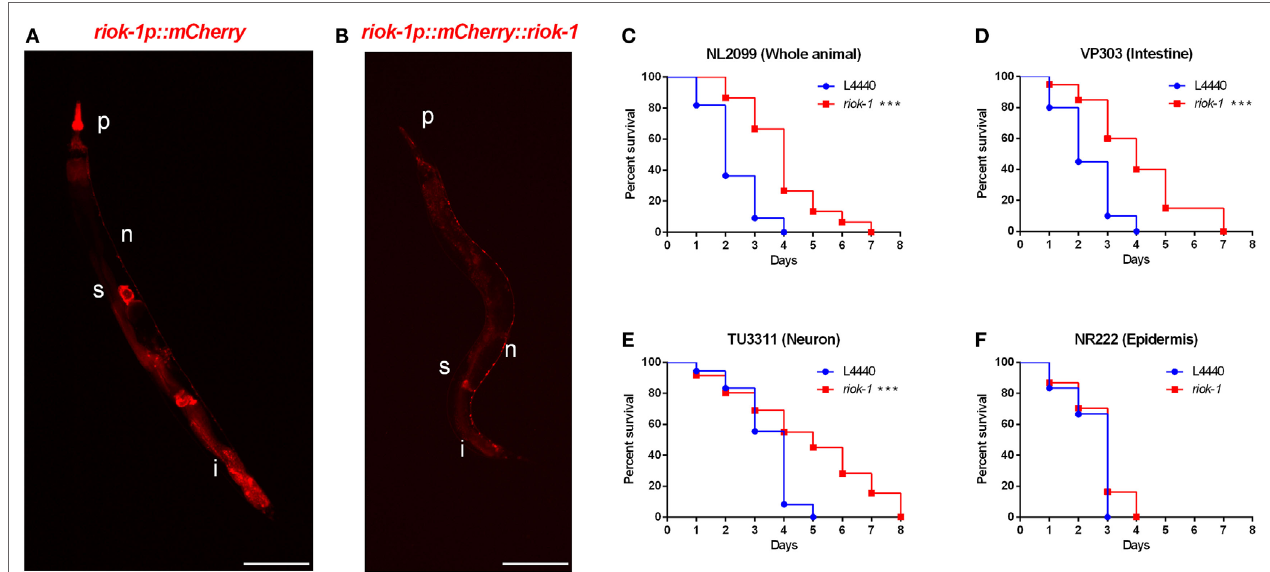
FigUre 3 | Tissue-specific knockdown of riok-1 in the intestines and neurons resulted in similar resistance to Aeromonas dhakensis as in worms with general riok-1 knockdown. (a) riok-1 is expressed in the pharynx (P), intestines (i), spermatheca (s), and pan-neuronally (n) in riok-1 transcriptional reporter worms. (B) riok-1 is expressed in the pharynx (p), intestines (i), spermatheca (s), and pan-neuronally (n) in translational reporter worms. (c–F) A. dhakensis resistance was seen in worms infected by A. dhakensis AAK1 with tissue-specific knockdown of riok-1 in the whole body (c) , intestines (D) , and neurons (e) in contrast to non-resistance to A. dhakensis among those with riok-1 knockdown in the epidermis (F) *** P < 0.001. The scale bars in (a,B) are both 100